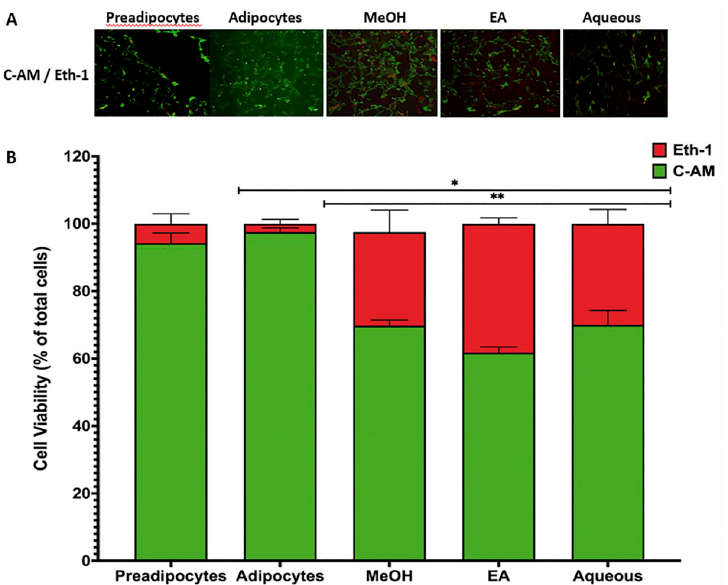
Fig 2. Live-dead staining showing the effect of B . spergulifolius extracts on cell viability in 3T3-L1 adipocytes. Live-dead staining assay was performed preadipocytes, mature adipocytes without and mature adipocytes with treated with IC 50 dose of MeOH, EA and Aqueous of B . spergulifolius extracts for 24 h A. Representative microscopic images at 10X magnification showed 3T3-L1 cells without and treated with B . spergulifolius extracts stained with Calcein- Acetomethoxy (C-AM) and Ethidium homodimer-1 (Eth-1). C-AM (green fluorescence) and Eth-1 (red fluorescence) staining showed respectively live and dead 3T3-L1 cells (Scale bar: 100 μ m) B. Quantitative data of live-dead staining assay. Three coverslips for each cell group were evaluated. Six distinct-randomly chosen regions in each coverslip were visualized and analyzed using microscope and ImageJ software. Data are expressed as a total percentage of viable and dead cells and presented as the means ± SD. To analyze statistical was used Student’s t-test (two-tailed). � p < 0.05, significantly different from mature 3T3-L1 Adipocytes. �� p < 0.05, significantly different from Aqueous.